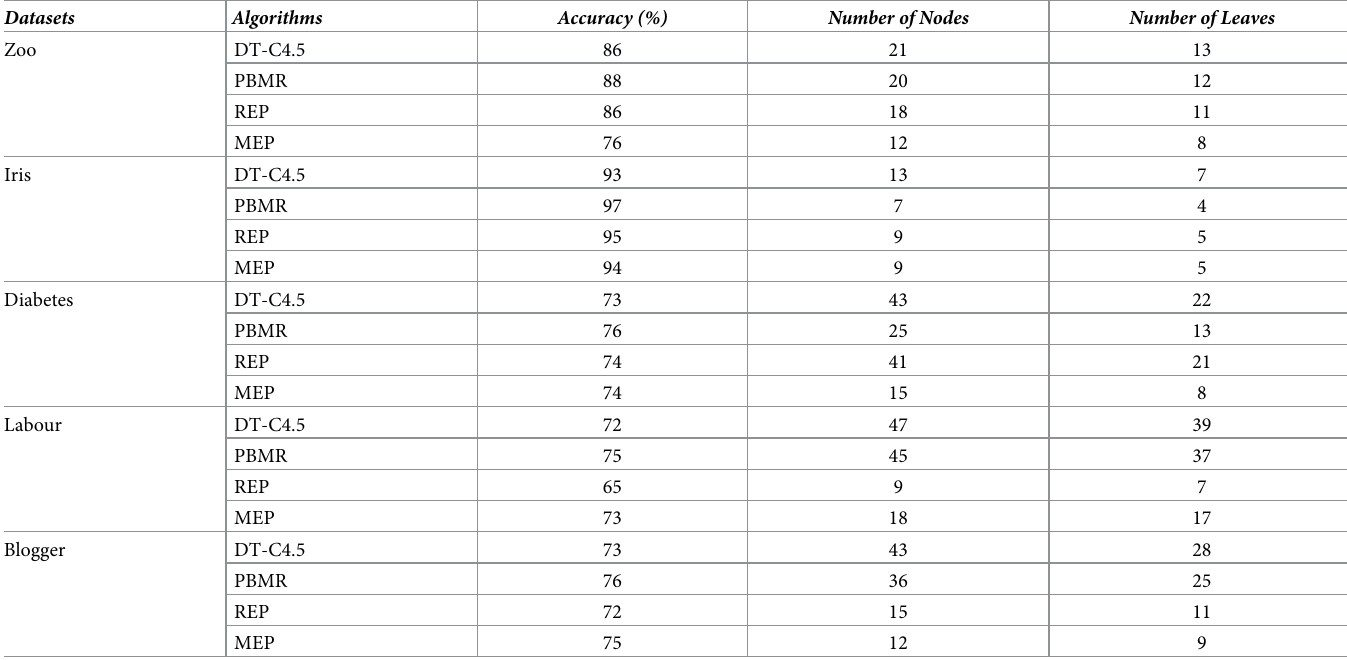
Table 5. Accuracy and tree size for PBMR, REP and